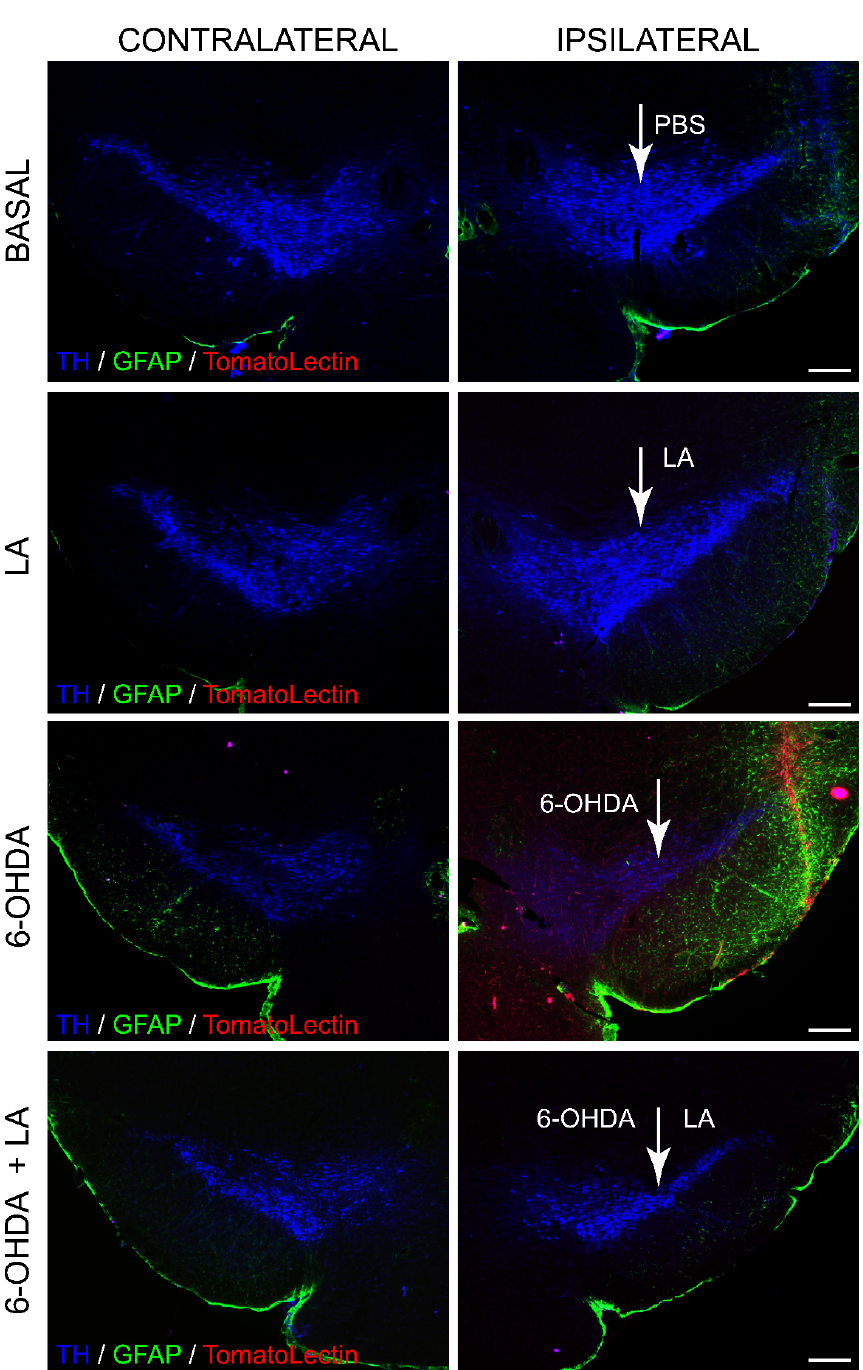
Figure A1. Neuroprotective and anti-inflammatory effect of LA on a hemiparkinsonian animal model. Representative images of coronal sections of the mouse SNpc showing the presence of dopaminergic neurons (TH, blue); astroglial cells labeled with glial fibrillary acidic protein (GFAP, green) and Tomato lectin (red) as a marker of activated microglial cells, both in the contralateral (not injected) and ipsilateral (injected) hemisphere. Scale bar, 200 µ